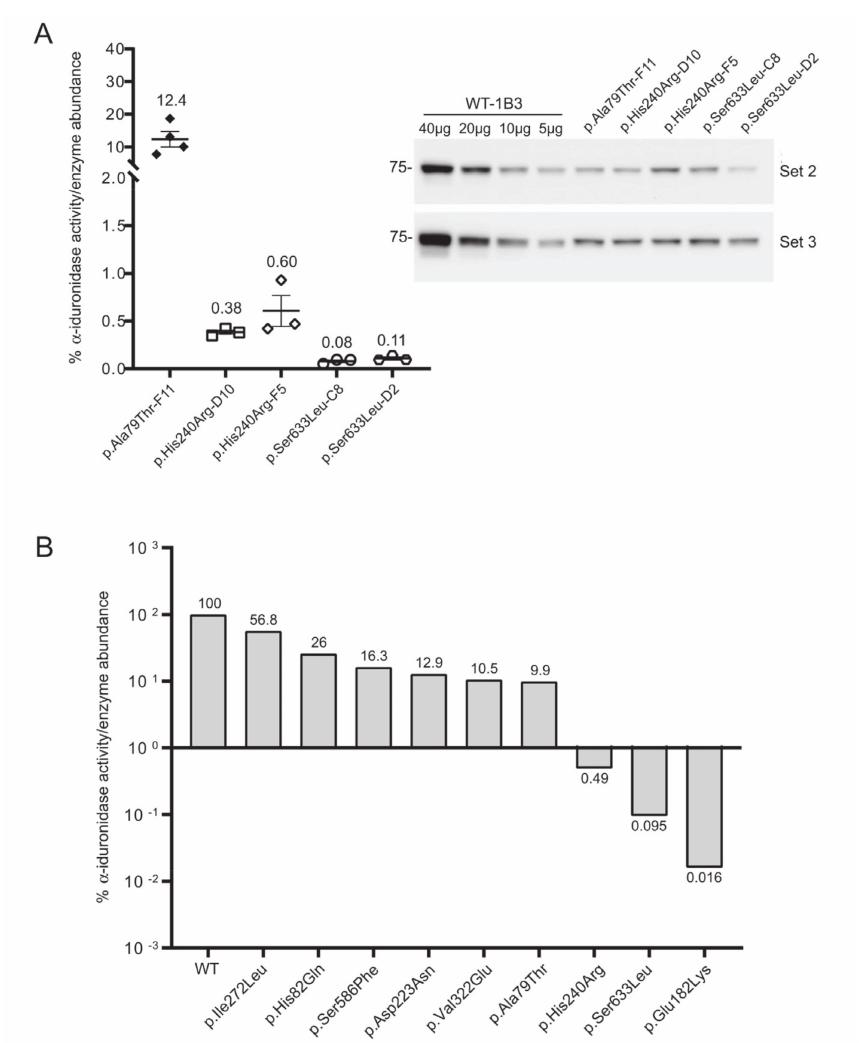
Figure 5. ( A ) Repeat analysis of the p.His240Arg and p.Ser633Leu variants using two di ff erent clones for each variant. Average relative specific activity is shown. Error bars represent standard error of the mean. ( B ) Summary of relative specific activity for all variants in this